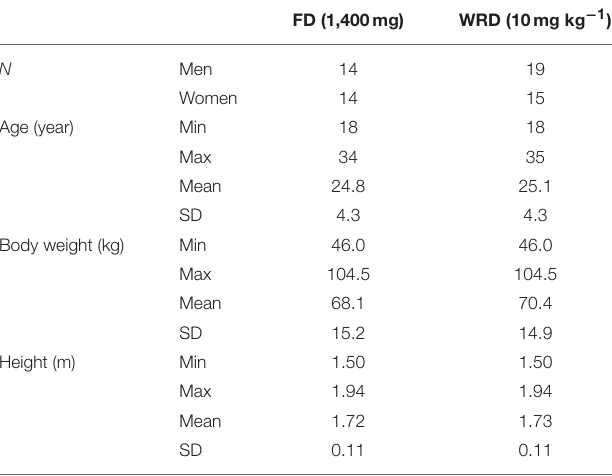
TABLE 1 | Anthropometric characteristics